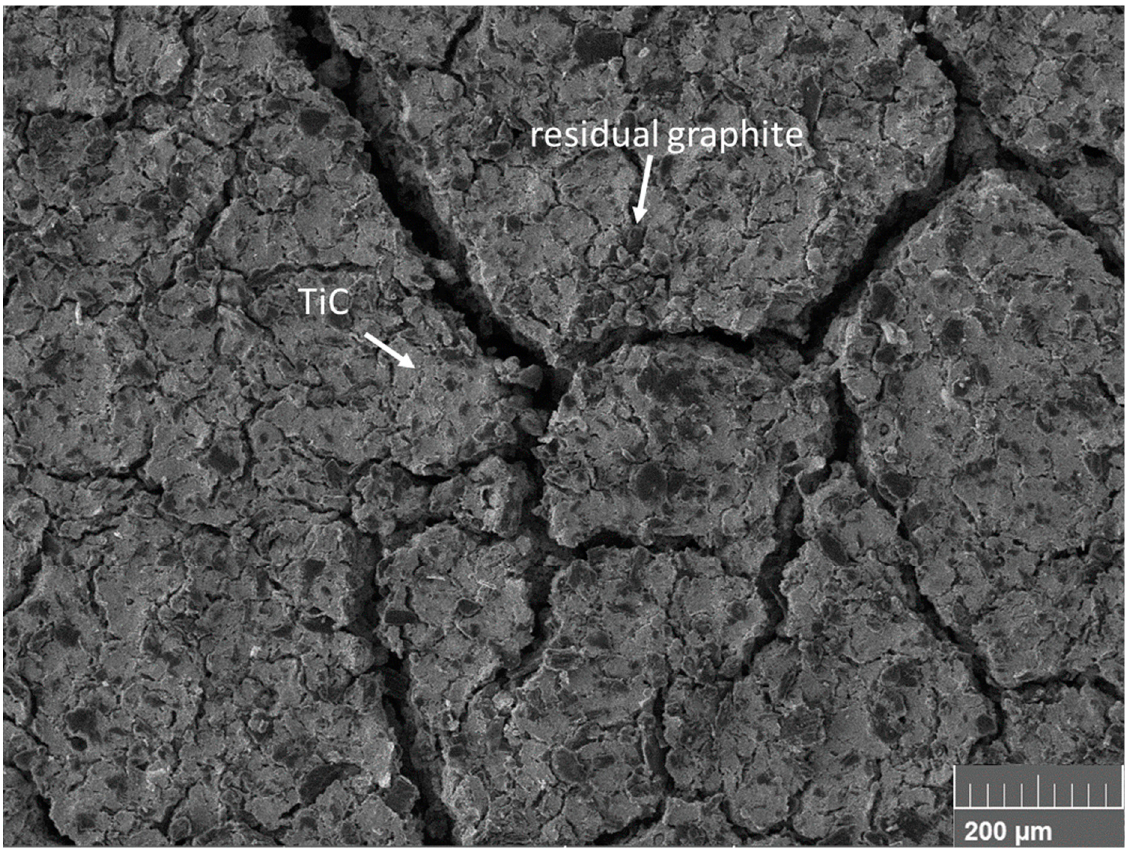
Figure 2. SEM picture of the flat surface of a TiC specimen.